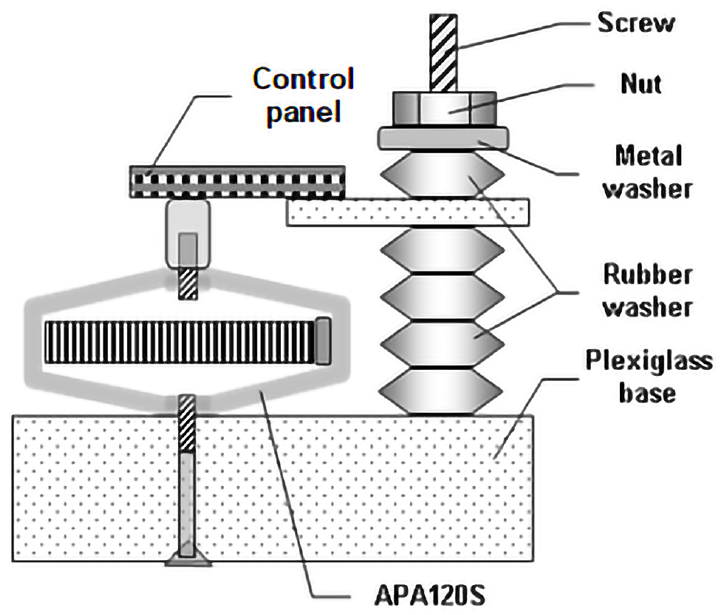
Figure 3. APA120S actuators placement underneath the control panel.